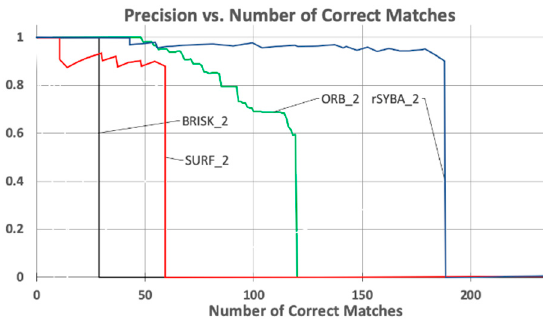
Figure 10. Precision comparison of rSYBA, SURF, BRISK, and ORB for the Boat image sequence.